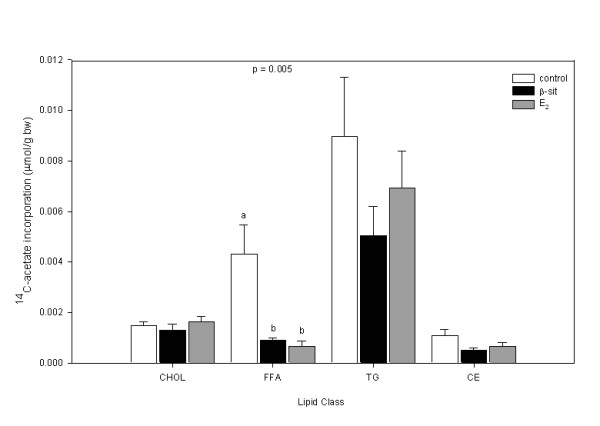
Gonad lipid 14C-acetate incorporation (μmol/g bw) toward cholesterol (chol), free fatty acid (FFA), triglyceride (TG) and cholesterol ester (CE) in male goldfish exposed to control, β-sit (200 μg/g) and E2 (10 μg/g) via Silastic® implants for 21 days. Values are presented as means ± SE. Different letters indicate treatments that are significantly different (p < 0.05).